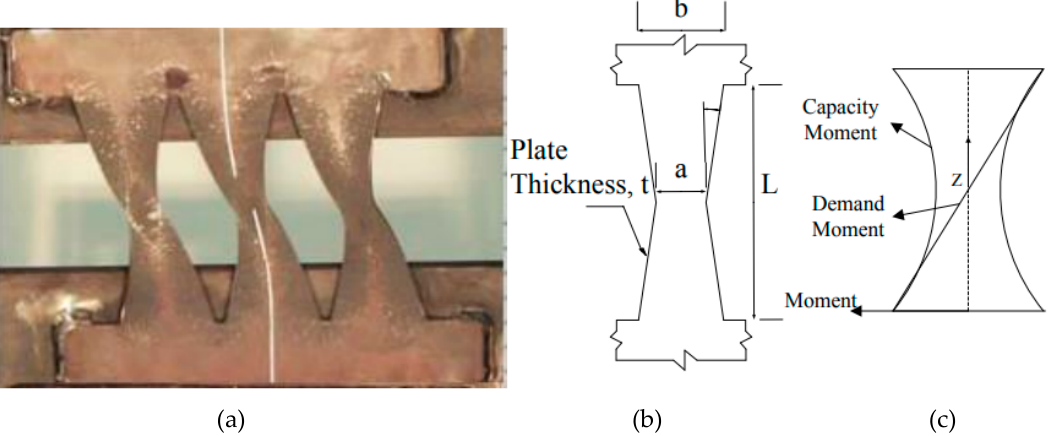
Figure 1. The butterfly-shaped hysteretic damper. ( a ) Butterfly-shaped plate (from [8] ); ( b ) Geometry; ( c ) Moment diagram.